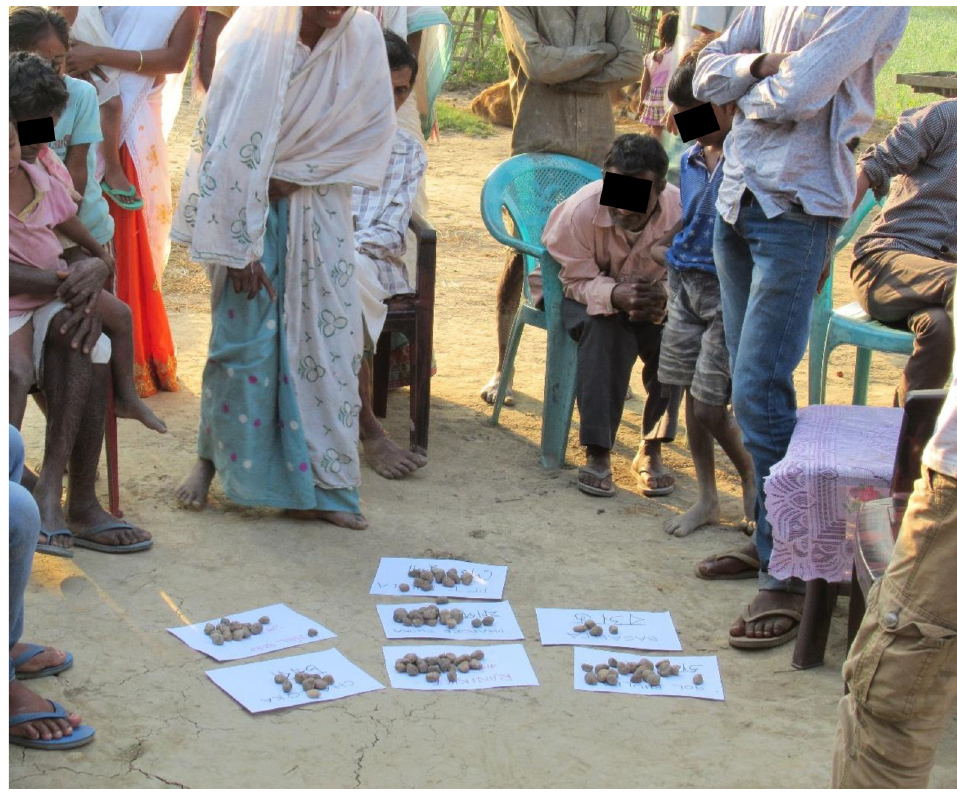
Fig 3. During a proportional piling exercise, a female farmer re-distributes some of the stones laid down by her neighbours to reflect her opinions on the relative importance of various animal health conditions.